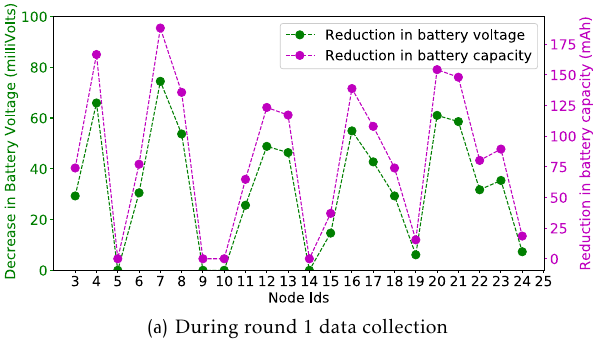
Figure 30. Node yield at the sink node for data collection round 2, test case 3